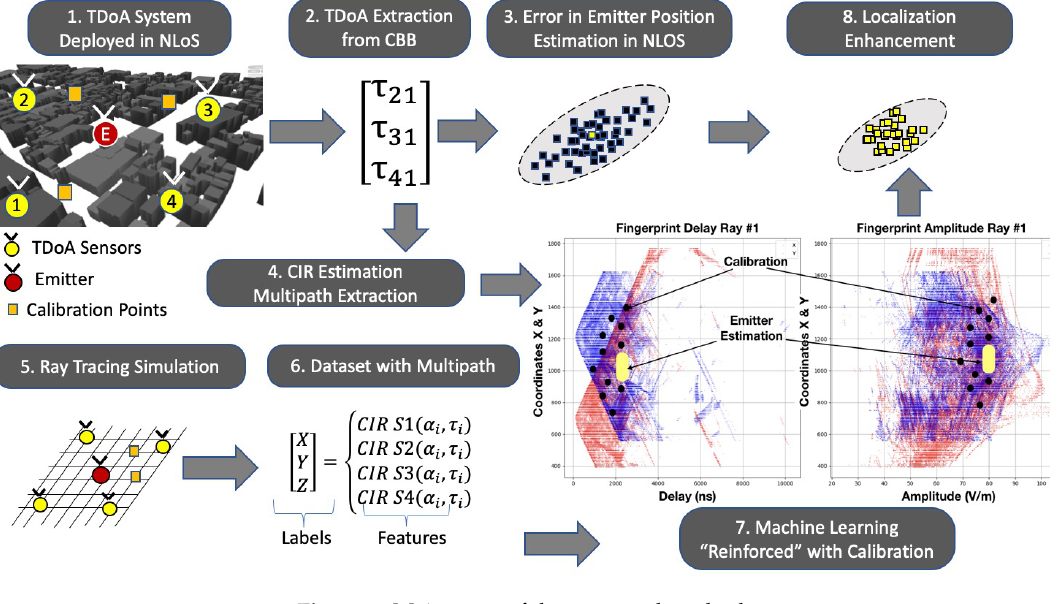
Figure 6. Main steps of the proposed method.